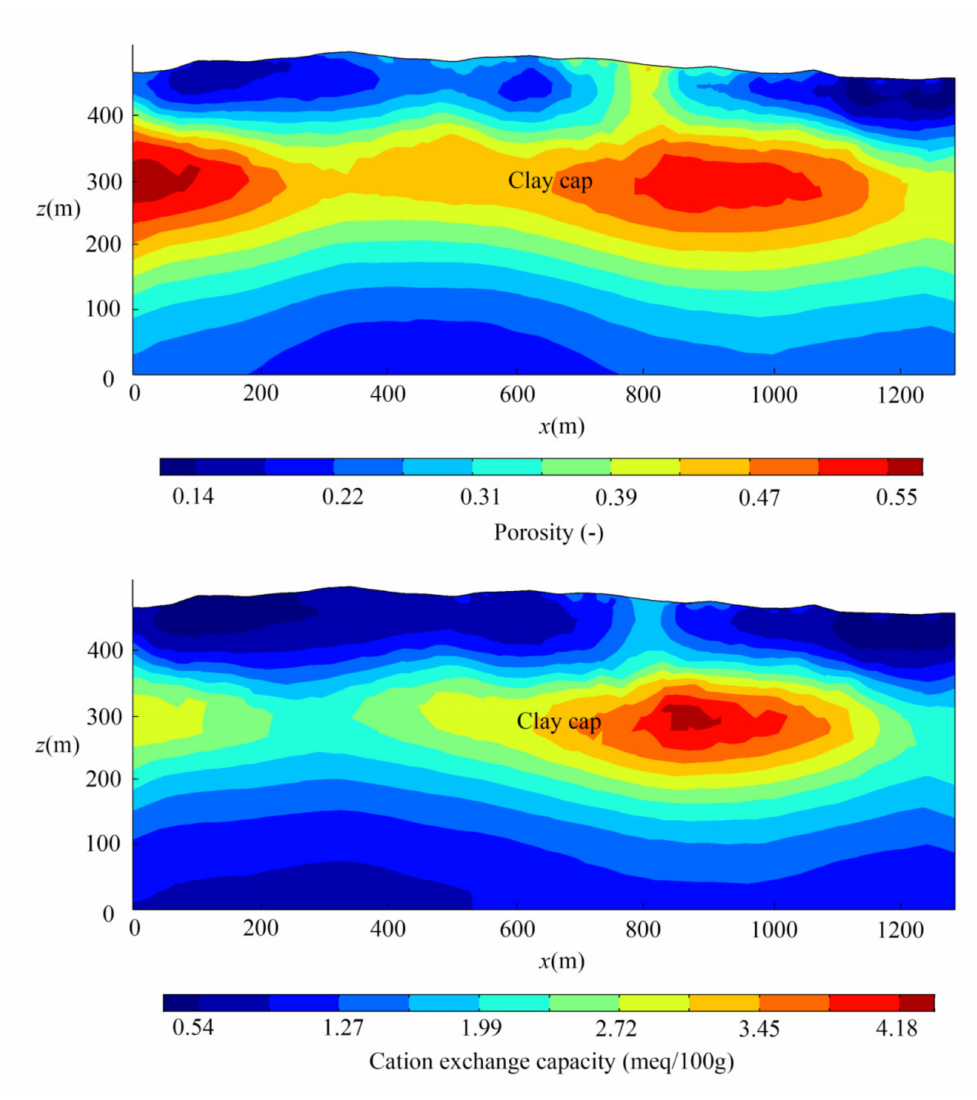
Figure 16. Imaging the porosity and CEC of a smectite-rich clay cap using Equations (4) and (5) using tomograms of the electrical conductivity and normalized chargeability